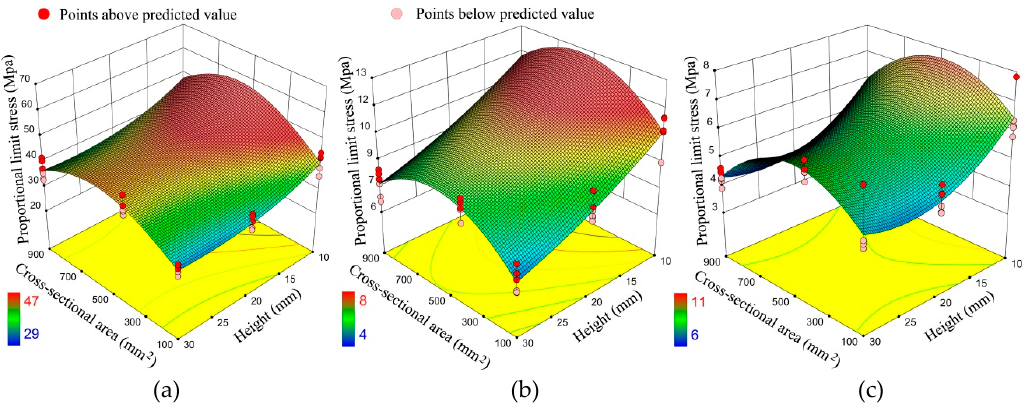
Figure 9. Relationships between proportional limits stress, cross-sectional area and height of specimens in longitudinal ( a ), radial ( b ) and tangential ( c ) grain orientations.